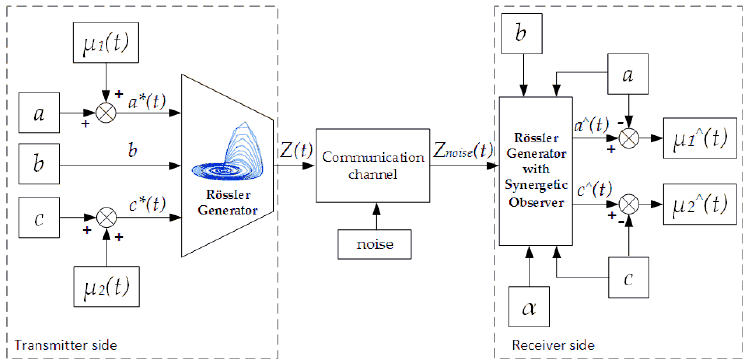
Figure 17. General block diagram of a synergetic observer communication system. Here: a , b , c are the known parameters of the chaotic generator model; a*(t) and c*(t) are the modulated parameters; Z(t) is the Rössler transformed system (2) variable; Z noise (t) is the Z(t) variable with noises admixed in the transmission media; aˆ(t) and cˆ(t) are the estimated modulated parameters; µ 1 (t) and µ 2 (t) are the initial useful signals; µ 1 ˆ(t) and µ 2 ˆ(t) are the reconstructed useful signals; and α is the observer tuning parameter. Table 2. Example of steps for our synergetic observer design procedure for Rössler generator. Design